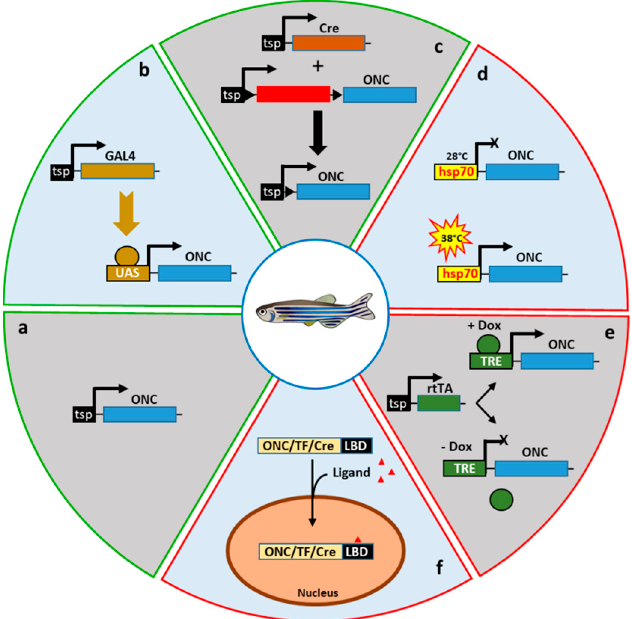
Figure 5. Strategies to control oncogene expression in zebrafish cancer models. ( a ) Spatial regulation of oncogene (ONC) expression through the activity of tissue-specific promoter (tsp). ( b ) The Gal4 / UAS system to enable cell type specific oncogene expression. The yeast transcription factor Gal4 is expressed through the control of a tissue-specific promoter (tsp) and binds to the upstream activating sequence (UAS) to drive the expression of the oncogene (ONC). ( c ) Cre-mediated oncogene (ONC) expression. Cre-mediated recombination removes an intervening sequence and places the oncogene under the control of a promoter. ( d ) Temporal oncogene (ONC) activation through the induction of the activity of the heat shock promoter. ( e ) Temporal oncogene (ONC) activation using the Tet-ON system. The binding of doxycycline to rtTA allows the transcription factor to bind and activate transcription at tetO responsive elements (TRE)-containing promoters. ( f ) Ligand-dependent oncogene (ONC) activation. Fusing the ligand-binding domain (LBD) onto oncogenic transcription factors (MYC), transcription factors (LexA) or Cre recombinase confers ligand-dependent activities to these proteins. Strategies to spatially control oncogene expression are boxed in green, whereas temporal to control of oncogene expression is boxed in red.